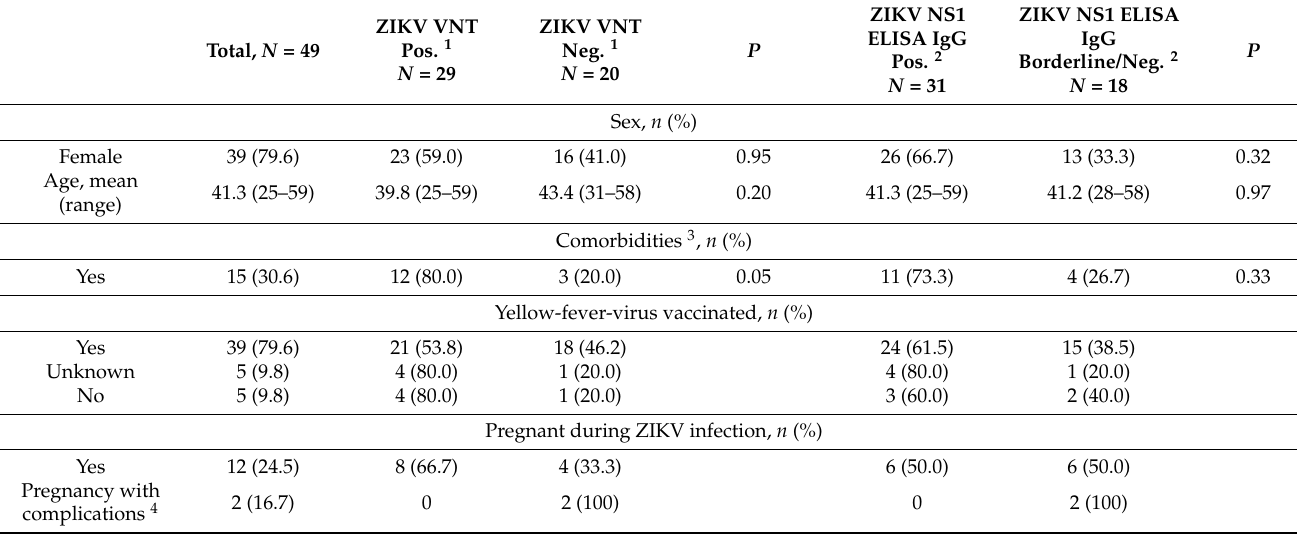
Table 1. Baseline characteristics of the total cohort and Zika and dengue-2 VNT positive/negative